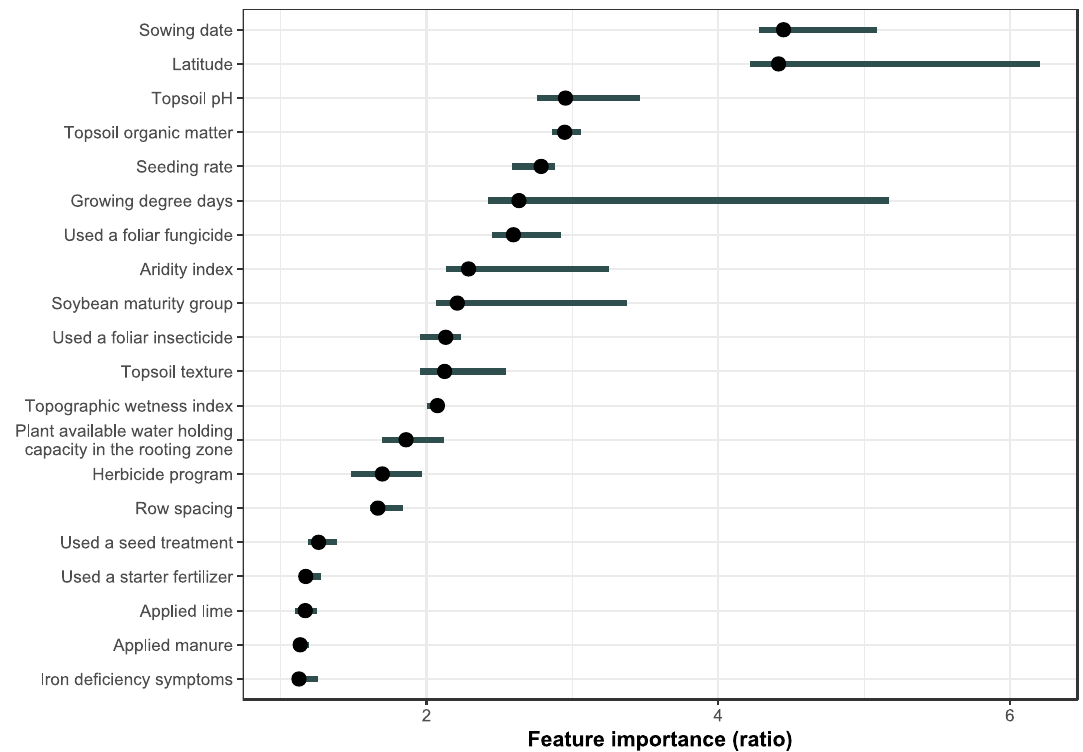
Figure 1. Importance of management-based variables in a random forest model predicting soybean yield. Feature importance was measured as the ratio of model error, after permuting the values of a feature, to the original model error. A predictor was unimportant if the ratio was 1. Points are the medians of the ratio over all the permutations (repeated 20 times). The bars represent the range between the 5% and 95% quantiles. Sowing date was the number of days from Jan 01. Growing degree days and the aridity index were annualized categorical constructs used within the definition of technology extrapolation domains (TEDs). Foliar fungicide or insecticide use, seed treatment use, starter fertilizer use, lime and manure applications were all binary variables for the use (or not) of the practice. Iron deficiency was likewise binary (symptoms were observed or not). Topsoil texture, plant available water holding capacity in the rooting zone, row spacing, and herbicide program were categorical variables with five, seven, five, and four levels, Focusing on model interpretation at the local level, we examined the Shapley φ values (see the “Methods” section for more information) associated with foliar fungicide applications for different subsets ( s ) and cohorts ( c ) of fields within the data (see Supplementary Table S1 online). The 1st subset ( s 1 ) was comprised of the 20 highest-yielding fields among those sprayed with foliar fungicides ( s 1 c 1 ) and the 20 highest-yielding fields among those which were not sprayed ( s 1 c 2 ) in each of the 12 technology extrapolation domains (TEDs) in the data matrix with adequate numbers of fields for comparisons (see also Supplementary Table S2 online; Supplementary Fig. S5 online maps the field locations within these 12 TEDs). A TED is a region (not necessarily spatially contiguous) with similar biophysical properties 41 . Predicted yields within these cohorts were mainly above the global aver- age of 3.79 t/ha, except in TED 602303 (Fig. 3), which corresponded to fields in North Dakota (Supplementary Fig. S5). In most cases Shapley φ values for foliar fungicide use exhibited a positive contribution to the yield